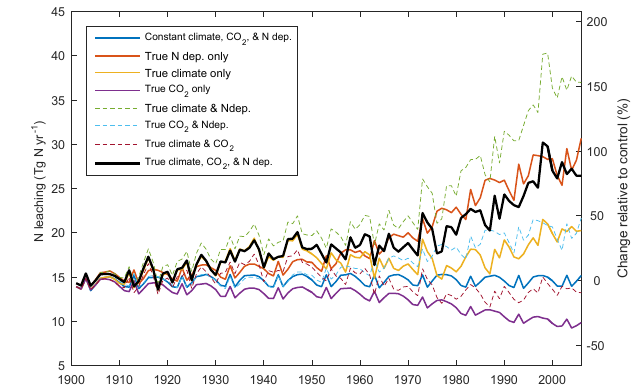
Figure 12. Global total N leaching for the eight simulations, for a world with potential natural vegetation only. The right-hand axis depicts change relative to the mean rate for the control simulation ( − Ndep − clim − CO 2